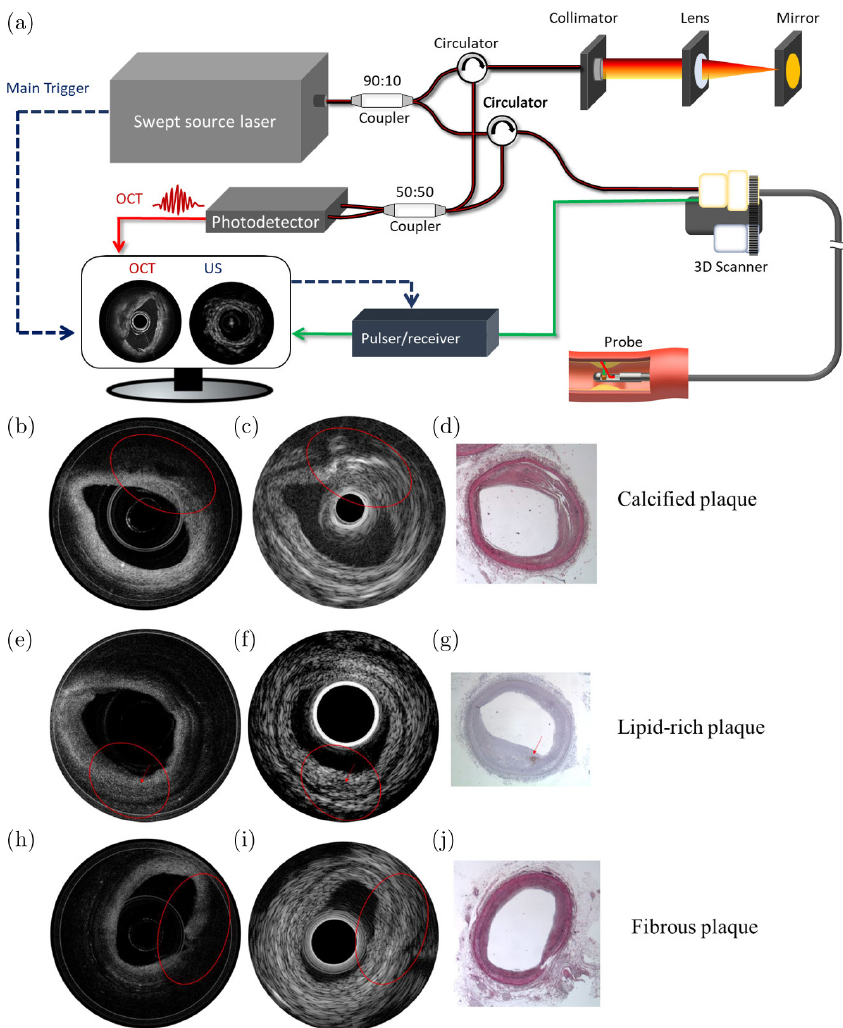
Fig. 1. Integrated IVUS-OCT. (a) A typical IVUS-OCT system schematic. (b) OCT, (c) IVUS, and (d) histology of a calci¯ed plaque. (e) OCT, (f) IVUS, and (g) histology of a lipid rich plaque. (h) OCT, (i) IVUS, and (j) histology of a ¯brous plaque. Adapted from Refs. 39 and